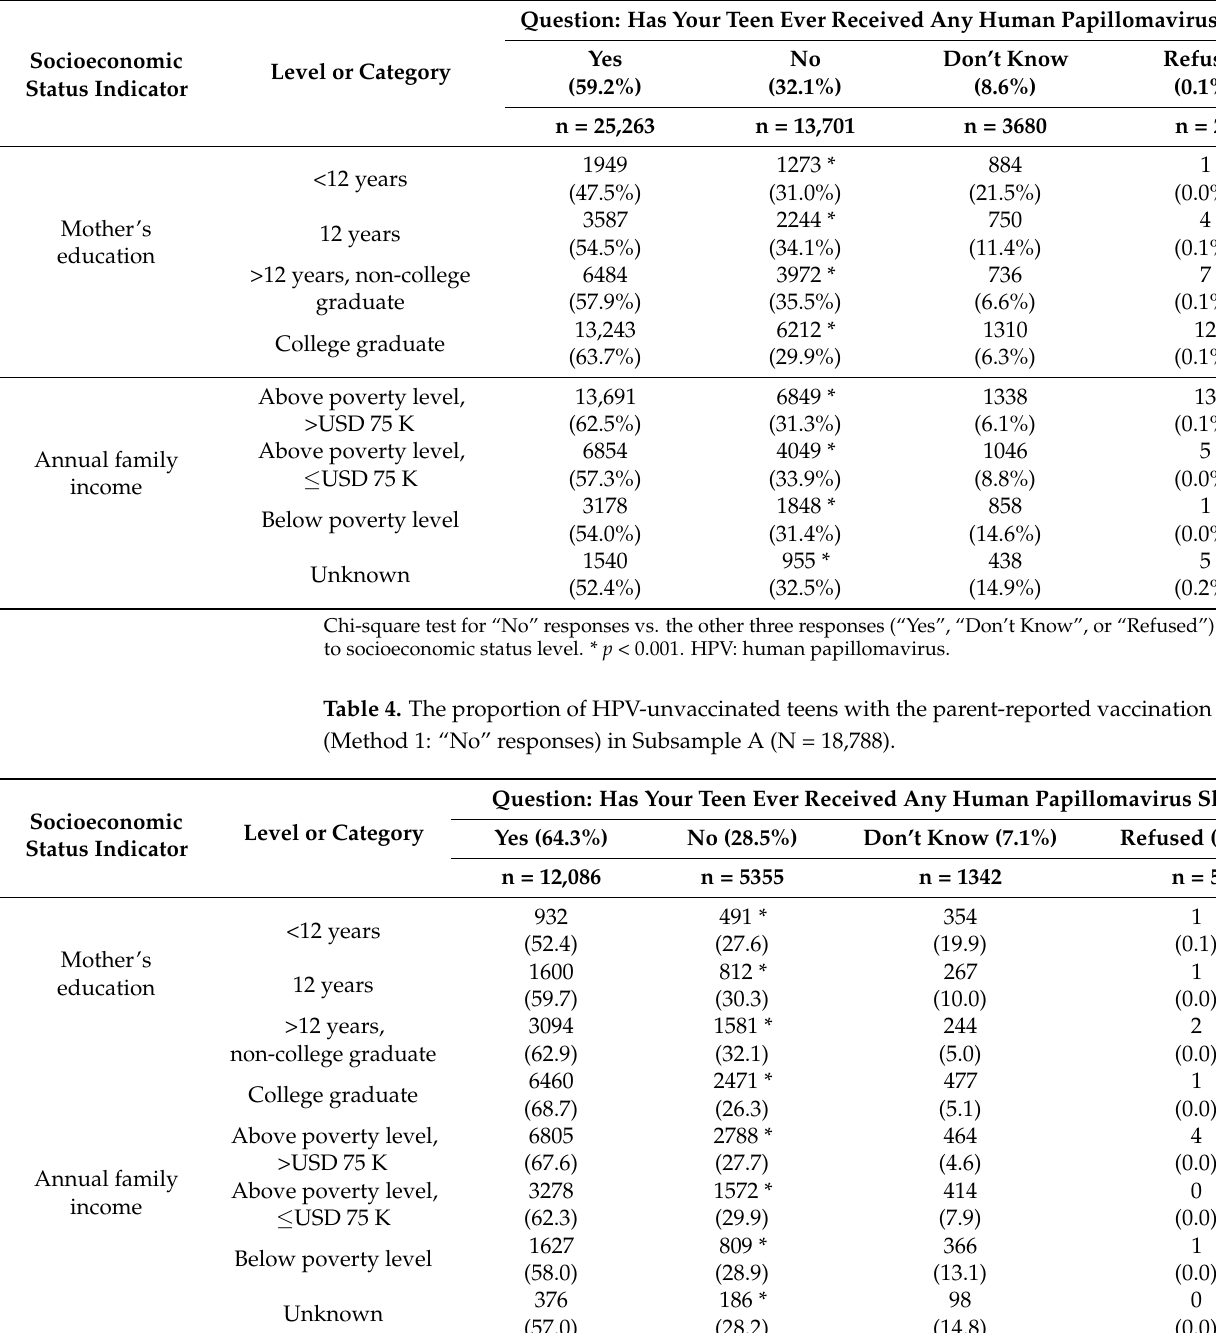
Table 3. The proportion of HPV-unvaccinated teens with the parent-reported vaccination response